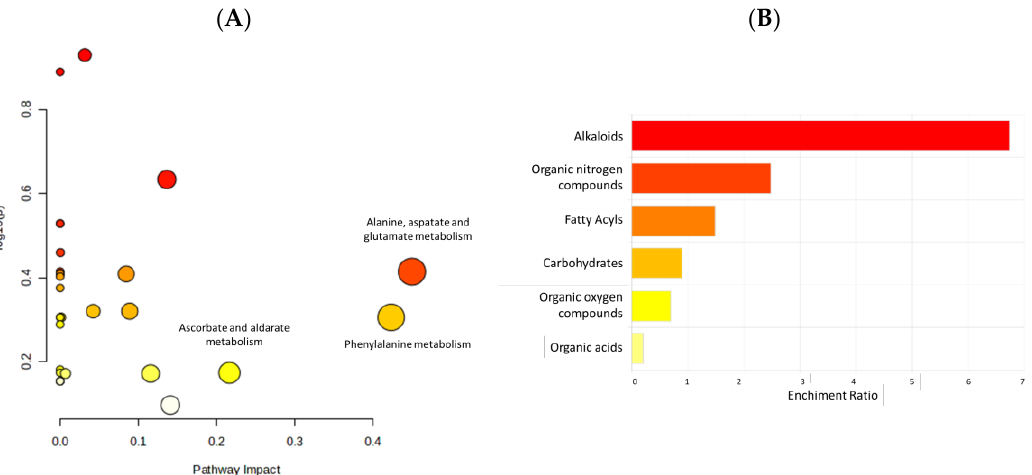
Figure 12. Pathway analysis. ( A ) Identification of the metabolic pathways of lemon juice samples altered by the variables studied (rootstock and culture medium). Pathways were considered significant when they presented a p -value < 0.05 and an impact factor > 0.2. ( B ) Bar graph resulting from the enrichment analysis of metabolites identified for the lemon juice samples.